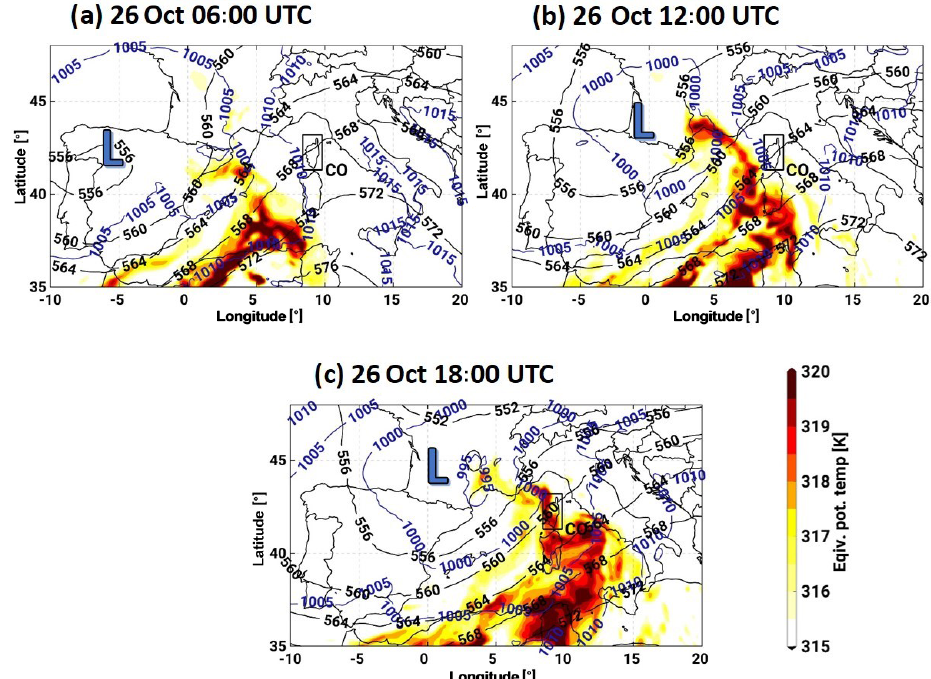
Figure 2. CTRL-7 simulation of 500hPa geopotential height in black isolines (gpdam), mean sea-level pressure in blue isolines (hPa) and equivalent potential temperature at 850hPa on a colour-coded scale (K) on 26 October 2012 at 06:00UTC (a) , 12:00UTC (b) and 18:00UTC (c)